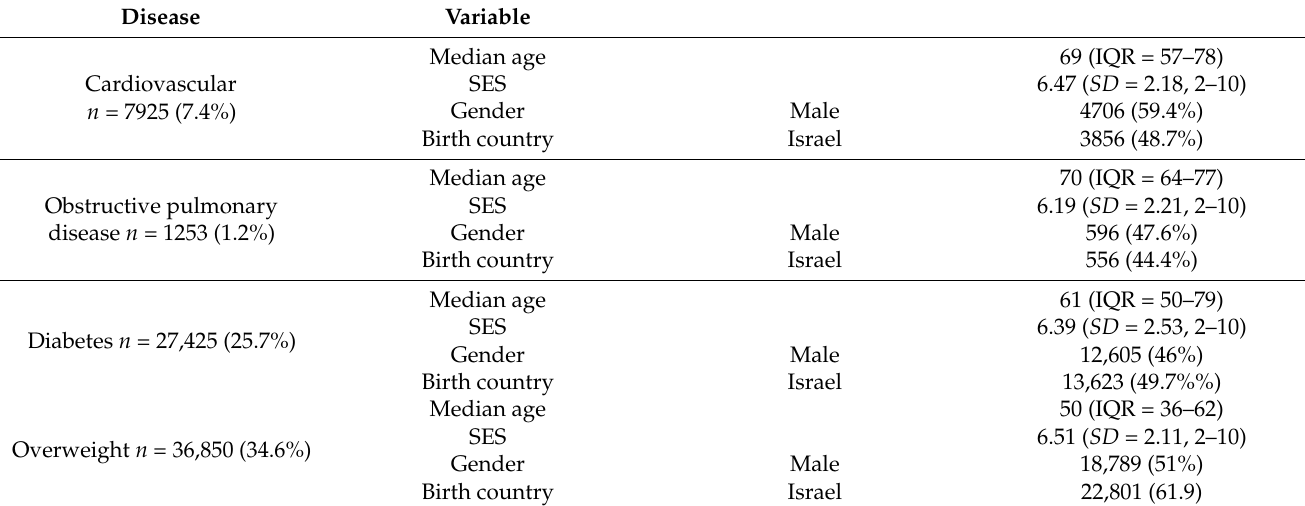
Table 2. Socio-demographic characteristics of study participants in different